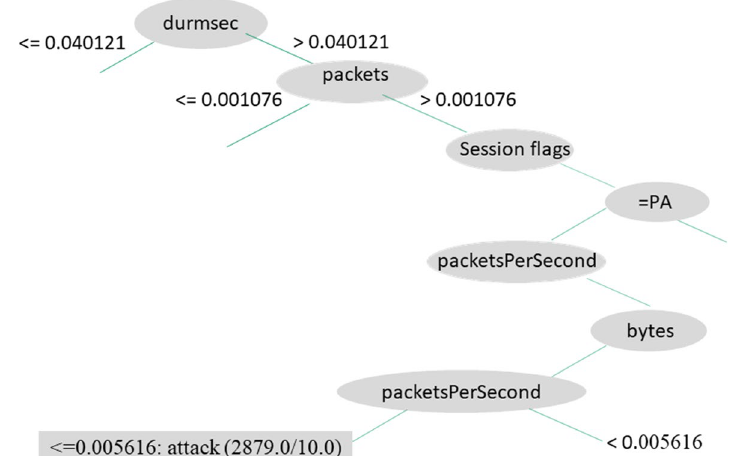
Fig. 9 C4.5D model tree 3